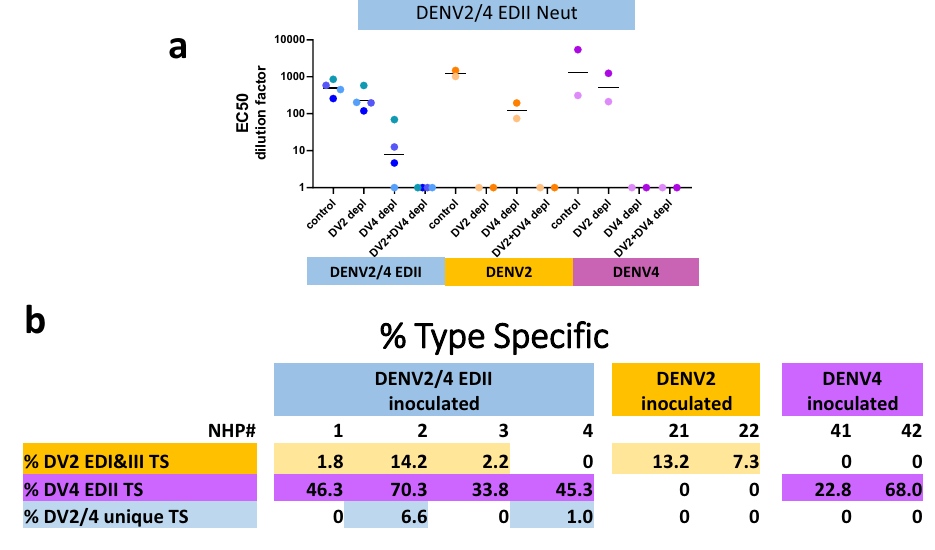
Fig.6|Identi fi cationofDENV2/4EDIITSAbs.a Type-Speci fi cAbstoDENV2/4EDII were identi fi ed in DENV2, DENV4 and DENV2/4EDII sera. Sera was depleted with BSA(control), DENV2, DENV4 or DENV2+DENV4 virions as described in the Methods. Background (DV2+DV4 depl) subtracted Vero-81 FRNT EC 50 values are shown. Individual EC 50 values are shown with a bar at the median value.